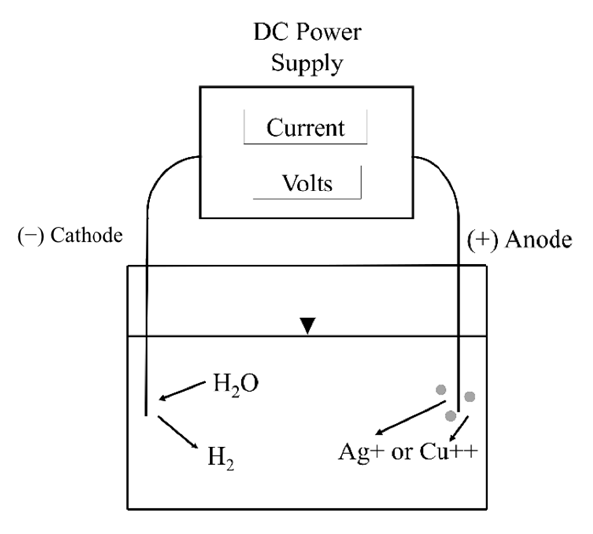
Figure 1. Basic configuration for lab experiments: a DC power source connected to two strands of coated wire each bearing an alligator clip. The clips held wire submerged in the appropriately sized, water-filled container. A determined voltage of electricity ran through the system, converting the H 2 O into H 2 gas and releasing metal ions into the water.